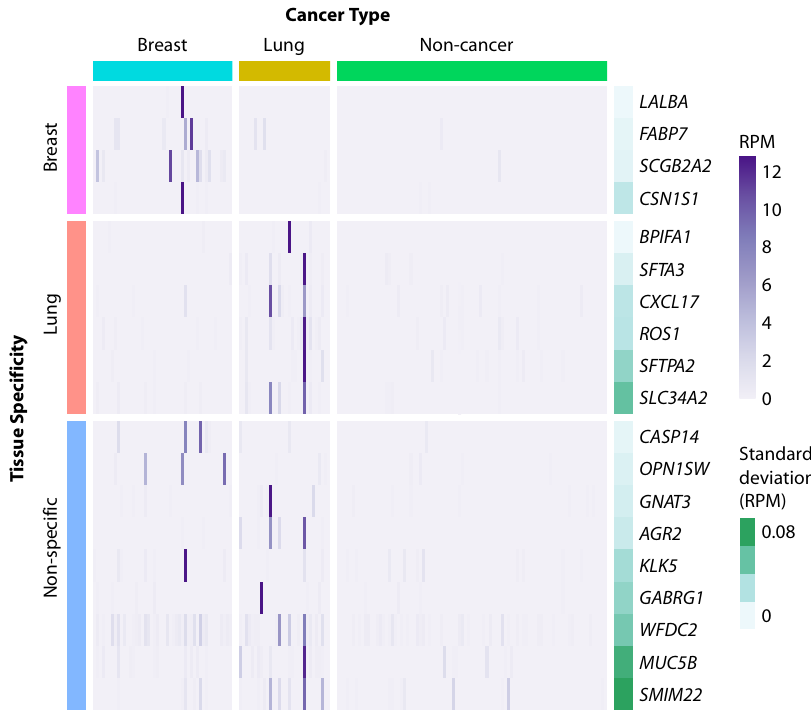
Fig. 3 Dark channel biomarker (DCB) expression in cell-free RNA from breast, lung, and non-cancer plasma samples. Samples are shown in columns and DCB genes in rows. Cancer type is indicated above the heatmap, and the tissue speci fi city of each DCB, as annotated in the Human Protein Atlas (version 18.1), is indicated on the left side of the heatmap. Gene expression values in reads per million (RPM) are represented by the purple gradient and are scaled for visualization purposes. Darkness in non-cancer plasma samples is illustrated by the standard deviation of RPM (green gradient bar) as shown on the right side of the